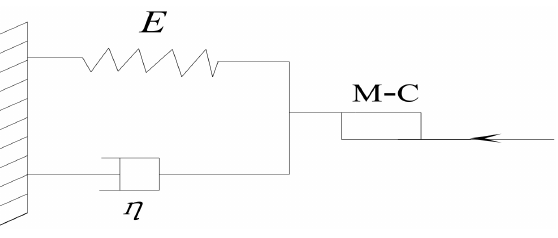
Figure 4. Modified Kelvin Nonlinear creep